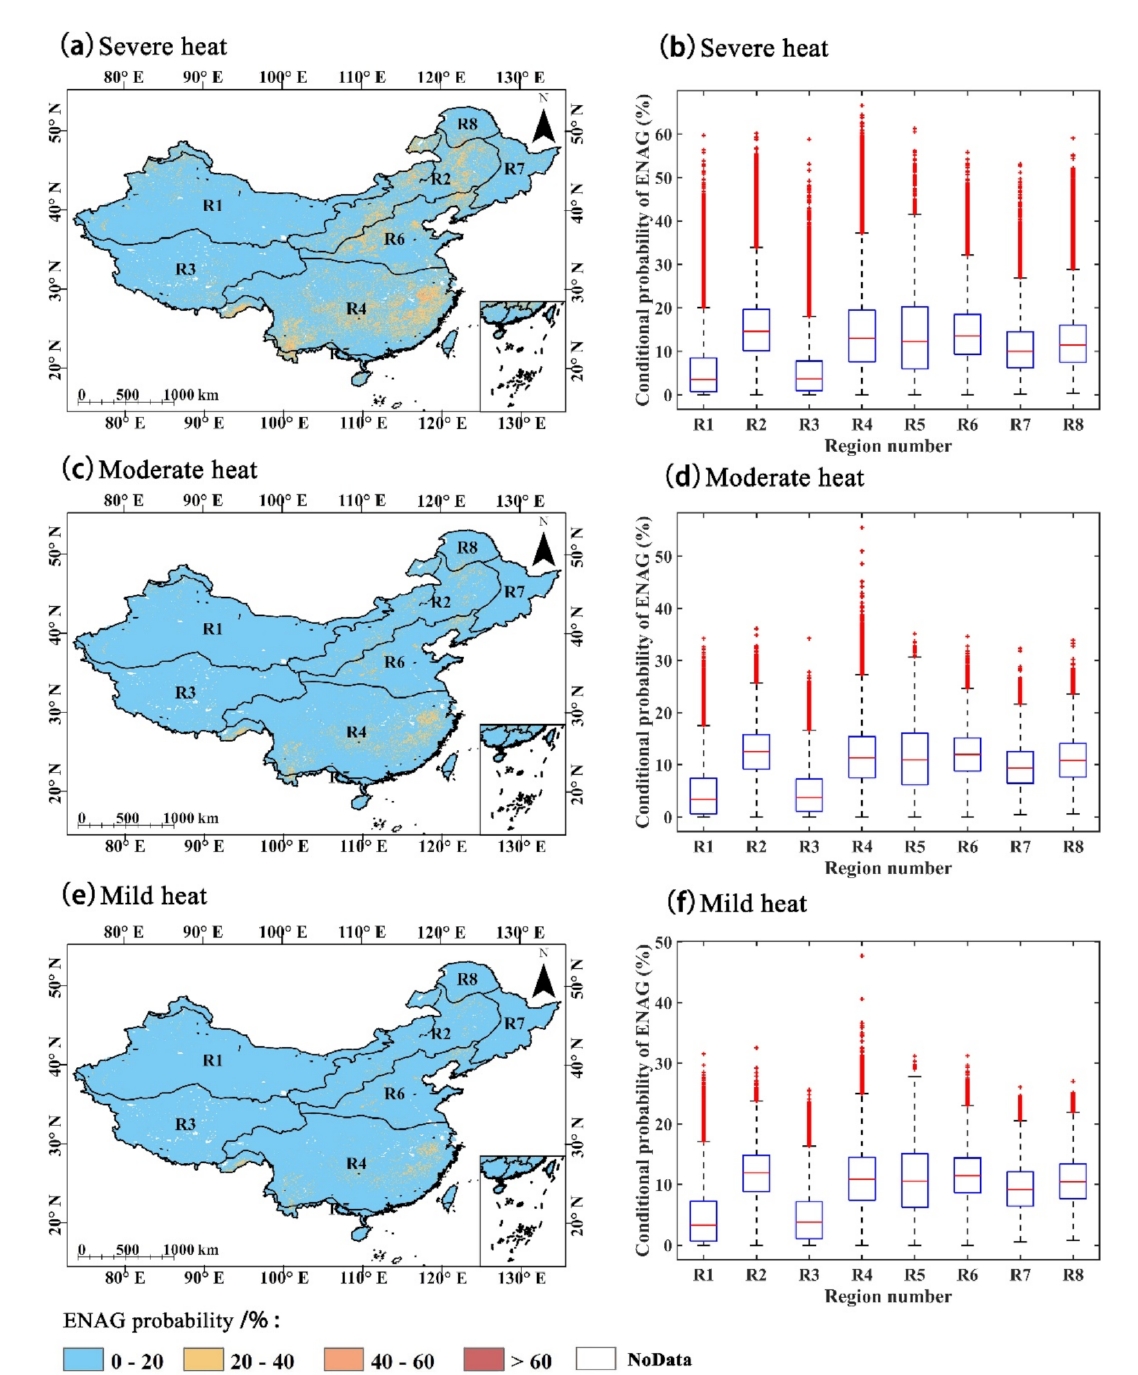
Figure 6. ENAG probabilities under different heat intensities. ( a , c , e ) represent the spatial distributions of the probabilities under severe, moderate, and mild heat, respectively; ( b , d , f ) represent the boxplots of ENAG probabilities in each vegetation region under severe, moderate, and mild heat, respectively (Note: the pixels displayed in white have the same meaning as Figure